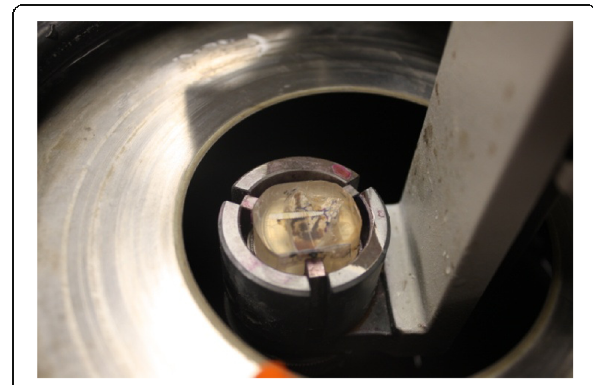
Fig. 3 Histological sections being obtained with Leica SP 1600 saw microtome